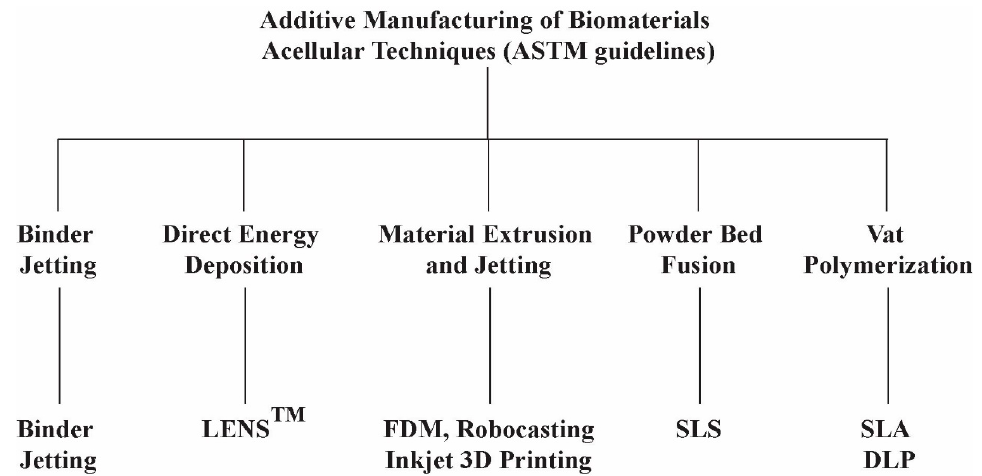
Figure 1. Different types of acellular techniques for biomaterials additive manufacturing (AM). Figure 1. Di ff erent types of acellular techniques for biomaterials additive manufacturing